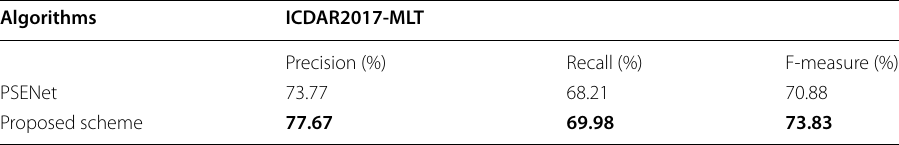
Table 4 Performance of test results on